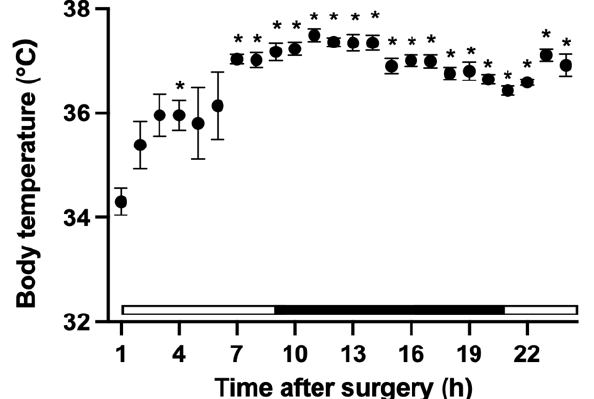
Figure 7. Changes in the core body temperature of mouse after surgery (n = 7). *, value differs ( p < 0.05) between 1 h after surgery and 4, 7, and 24 h after surgery. Differences in values ( p < 0.05) between other times are described in the text. The white bar indicates the light period in the animal room and the black bar indicates the dark period.